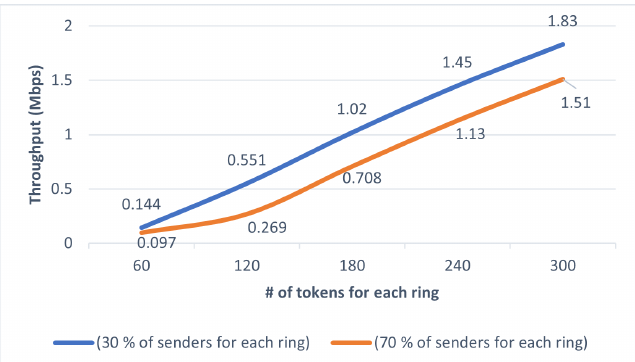
Figure 13. Throughput vs. numbers of tokens in Ring2Tor